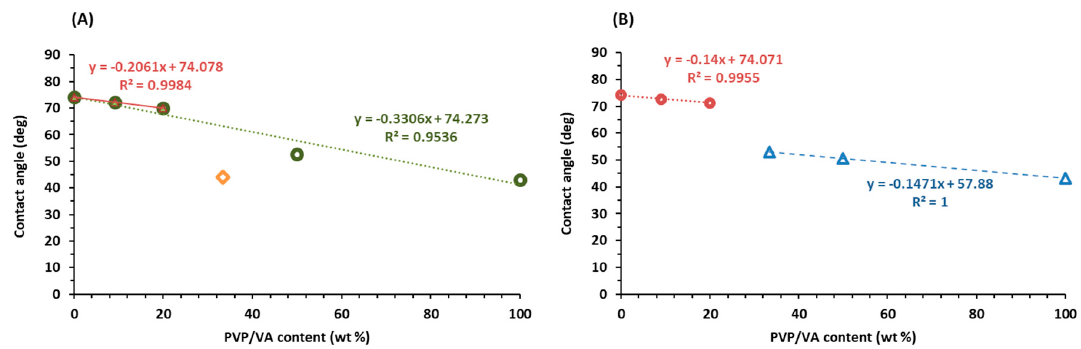
Figure 12. The values of contact angle of solid dispersions obtained by either ball milling ( A ) or spray drying ( B ).